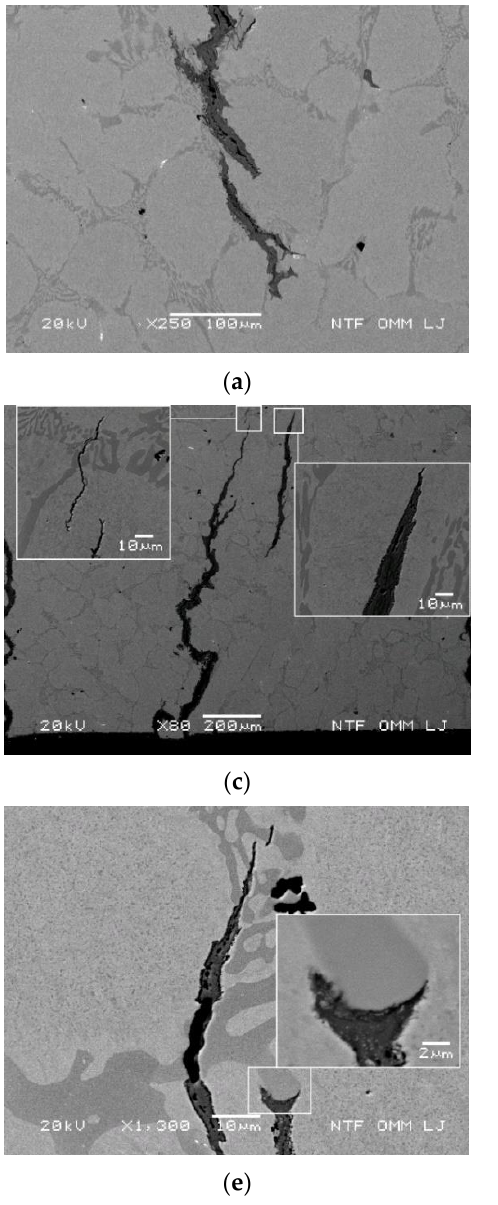
Figure 11. Influence of low effective thermal stress on oxidation behavior: ( a ) micrograph of increased straightness at the end of primary crack after 2500 cycles at 700 °C of the area A in Figure 8a; ( b ) crack in radial cross section and detailed view of the crack tip after 1000 cycles at 600 °C; ( c ) crack growth and formation of internal crack in carbide cluster located in the crack growth direction in the left detailed area, and detail on the right is crack growth in the matrix between eutectic carbides without internal crack at carbides; ( d ) crack canal oxidation and crack growth following the carbide/matrix interface observed after 1000 cycles at 700 °C; ( e ) formation of the internal crack in carbide before crack tip of the primary crack—(top) oxidation of carbide, and oxide branching at the larger carbide (bottom) after 2500 cycles at 700 °C; ( f ) oxidation of the carbide/matrix interface and oxidation direction deviation to the perpendicular orientation after 2500 cycles at 500 °C.